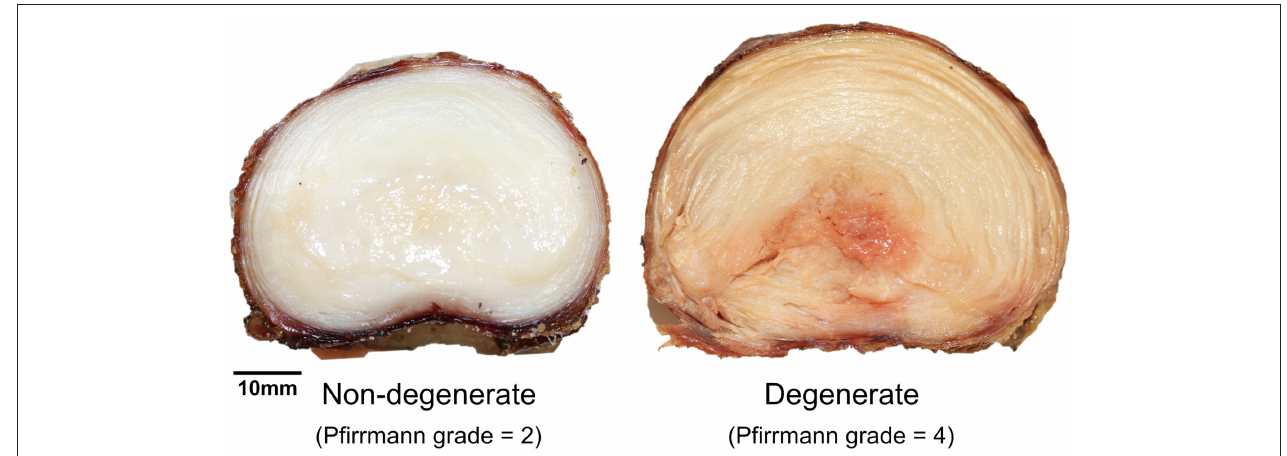
FIGURE 3 | Axial photographs of typical non-degenerate (left, Pfirrmann grade = 2, 26-year-old) and degenerate (right, Pfirrmann grade = 4, 53-year-old) samples taken during specimen dissection after the failure test.